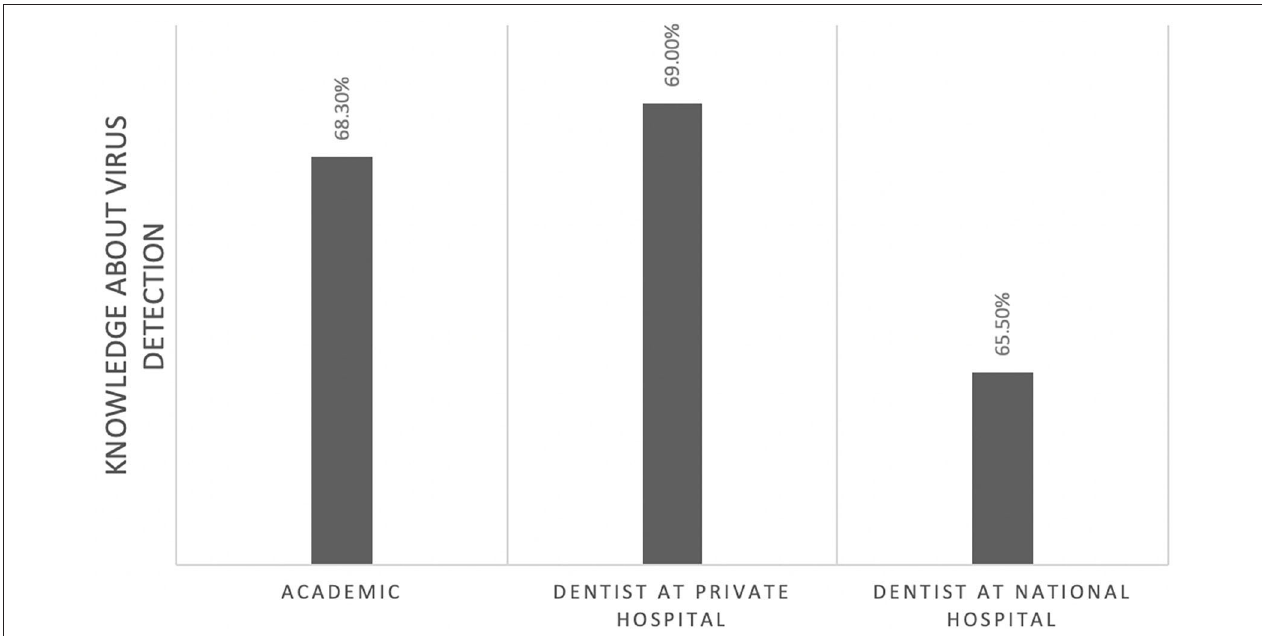
FIGURE 2 | Sixty-seven percent of the participants had comprehensive knowledge about virus detection. This knowledge was not associated with the professional affiliation ( p = 0.54).